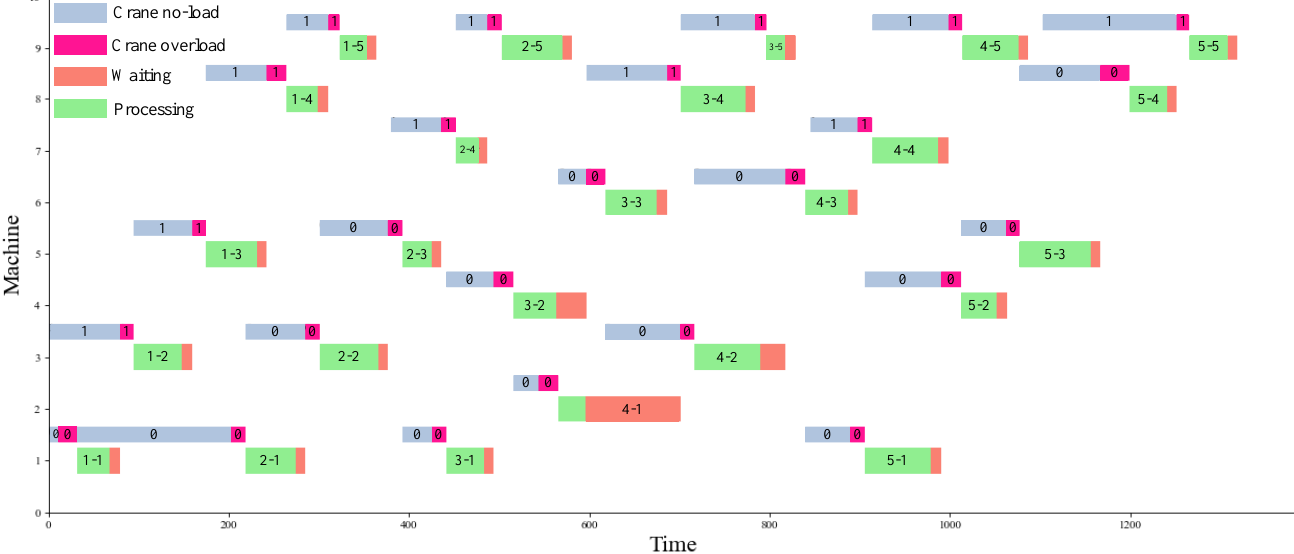
Figure 7. Scheduling Gantt chart (DRL-DT). DRL will directly consider uncertain disturbance factors such as equipment failure. When a fault is observed, the algorithm adaptively adjusts its choice of action. It is as- sumed that machine 1 and crane 0 failures occur at 400 s and 800 s respectively, during the scheduling execution process, and the failure time lasts for 100 s. At this time, the final time for each method to complete the scheduling is shown in Table 3. The obtained results show that the makespan of DRL-DT is still the smallest, which indicates that DRL-DT has the strongest ability to cope with failures. Table 3. Makespan (s) comparison of each method. Methods